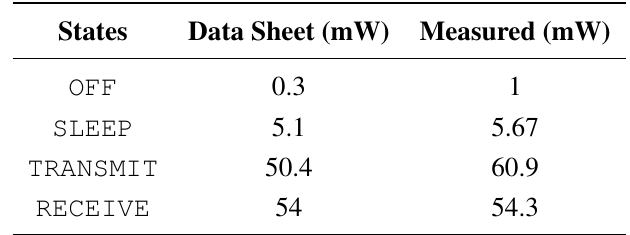
Table 2. Power consumption of the CC430 System on Chip (SoC) in the different states. The differences in OFF , SLEEP and RECEIVE are due to the static consumption of other onboard peripherals, e.g., temperature, humidity and acceleration sensor. The difference in TRANSMIT is due to a higher transmit power to compensate for additional RF losses, e.g.,